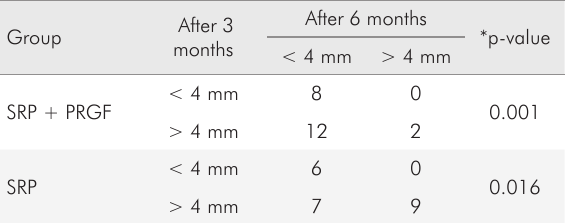
Table 4. Comparison of Probing depth assessment between the SRP+PRGF and SRP